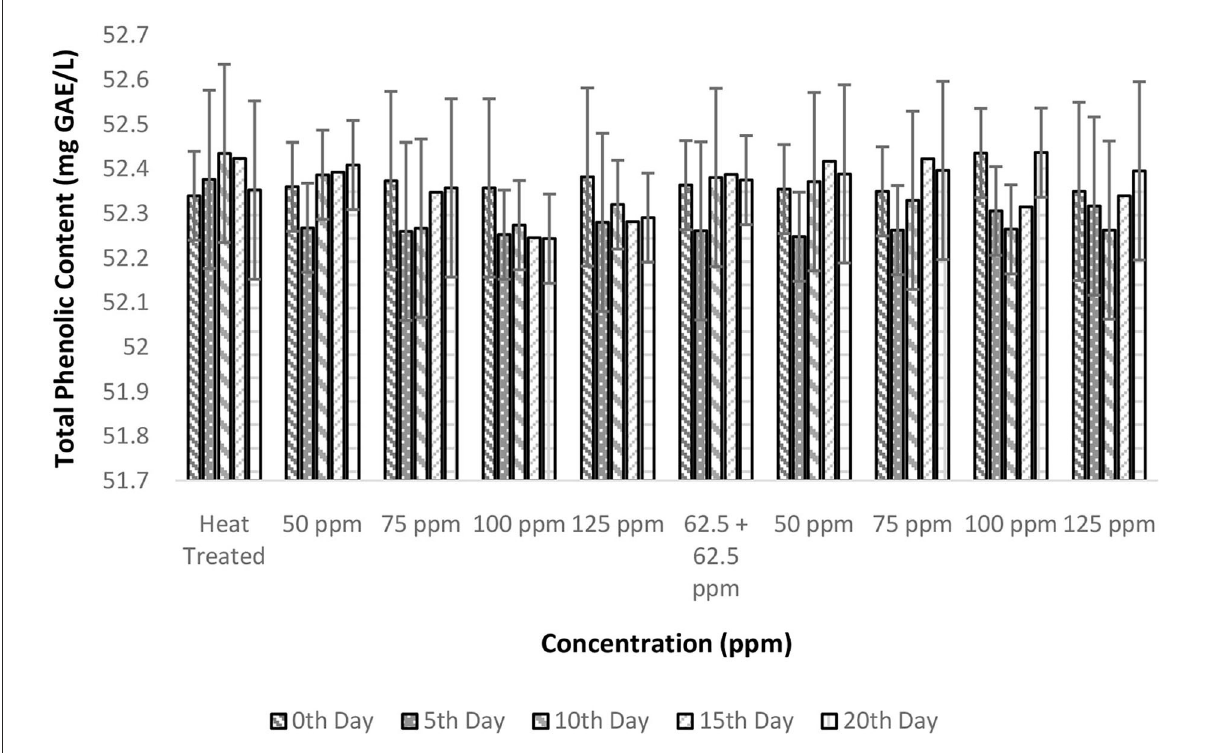
FIGURE7 Total phenolic content vs. concentration plot of bio-preservatives during the storage